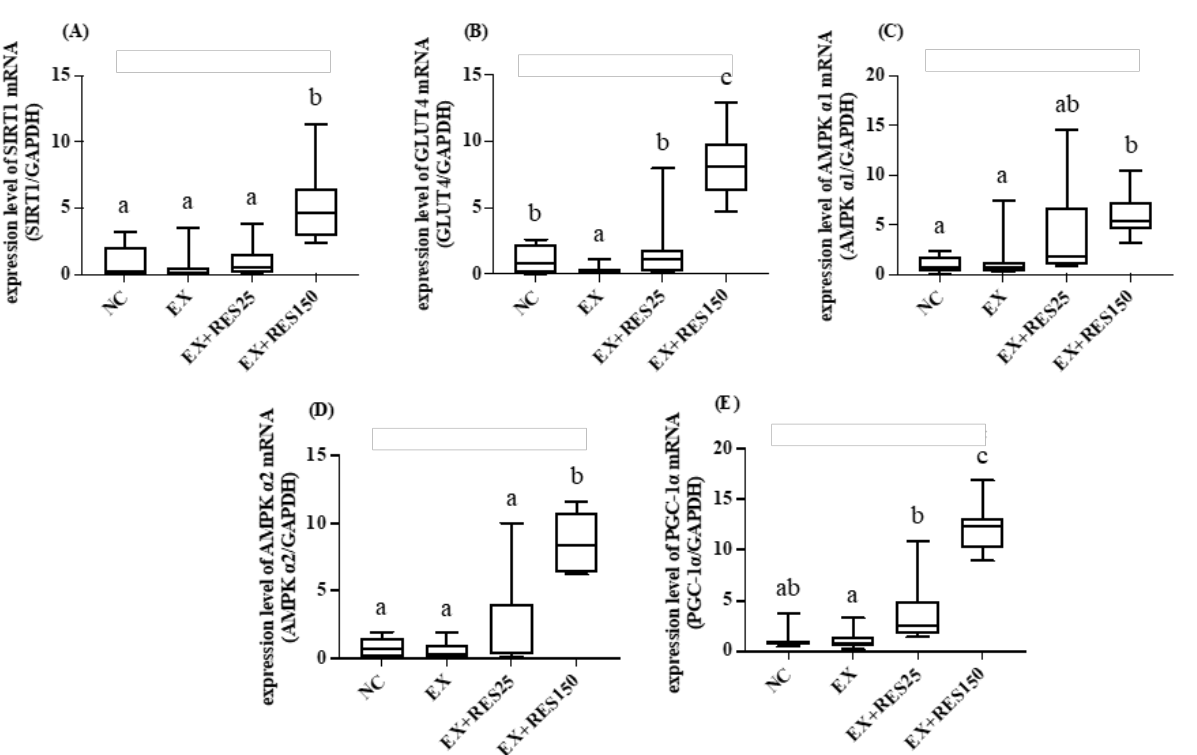
Figure 7. Effects of resveratrol on energy utilization and antioxidative mRNA expression in soleus muscle during short-duration downhill running training. ( A ) Sirt1 mRNA ( B ) Ampk α 1 mRNA ( C ) Amp α 2 mRNA ( D ) Glut4 mRNA ( E ) Pgc1 α mRNA. mRNA expression was normalized to GAPDH and is expressed in terms of fold change relative to the control group. NC: control ( n = 6); EX: exercise 3.6. MA Plot, Volcano Plot, and Bar Charts for EX vs. EX + RES150 Groups